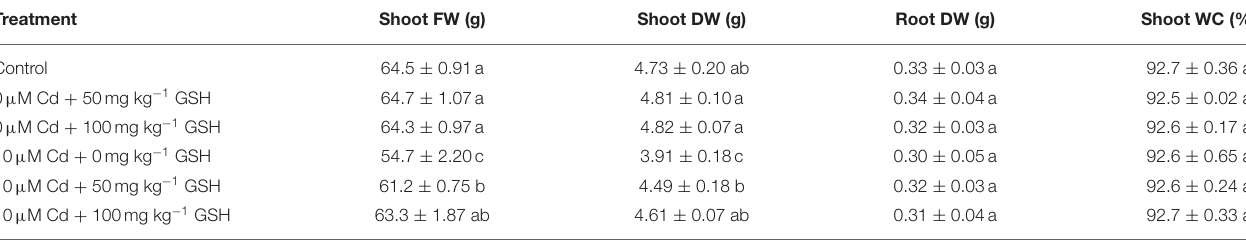
TABLE 1 | Shoot fresh weight (FW), shoot dry weight (DW), root DW, and shoot water content (WC) in oilseed rape plants grown under control [no cadmium (Cd) or glutathione (GSH)] or 0 and 10 µ M Cd stresses in with/without glutathione (GSH; 0, 50, and 100mg kg − 1 ) conditions.